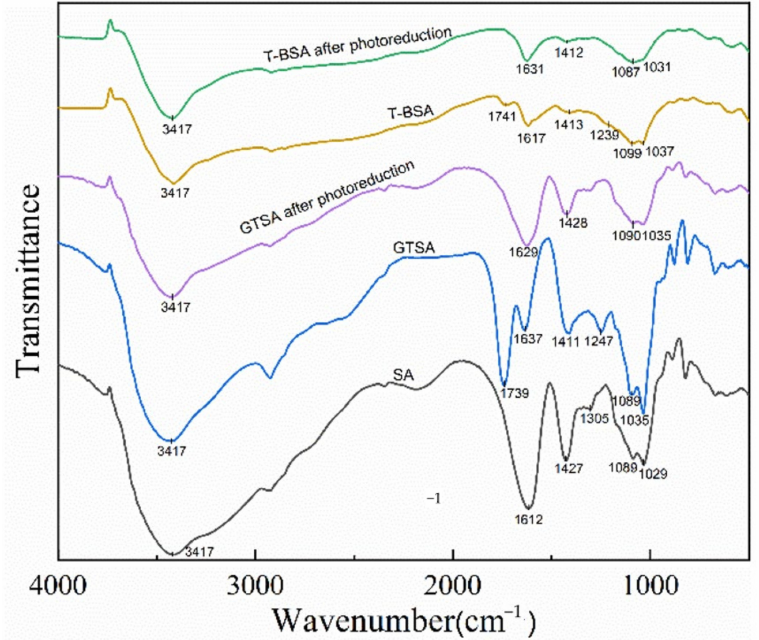
Figure 8. FT-IR spectra of SA, biochar, GTSA and T-BSA before and after Cr(VI)